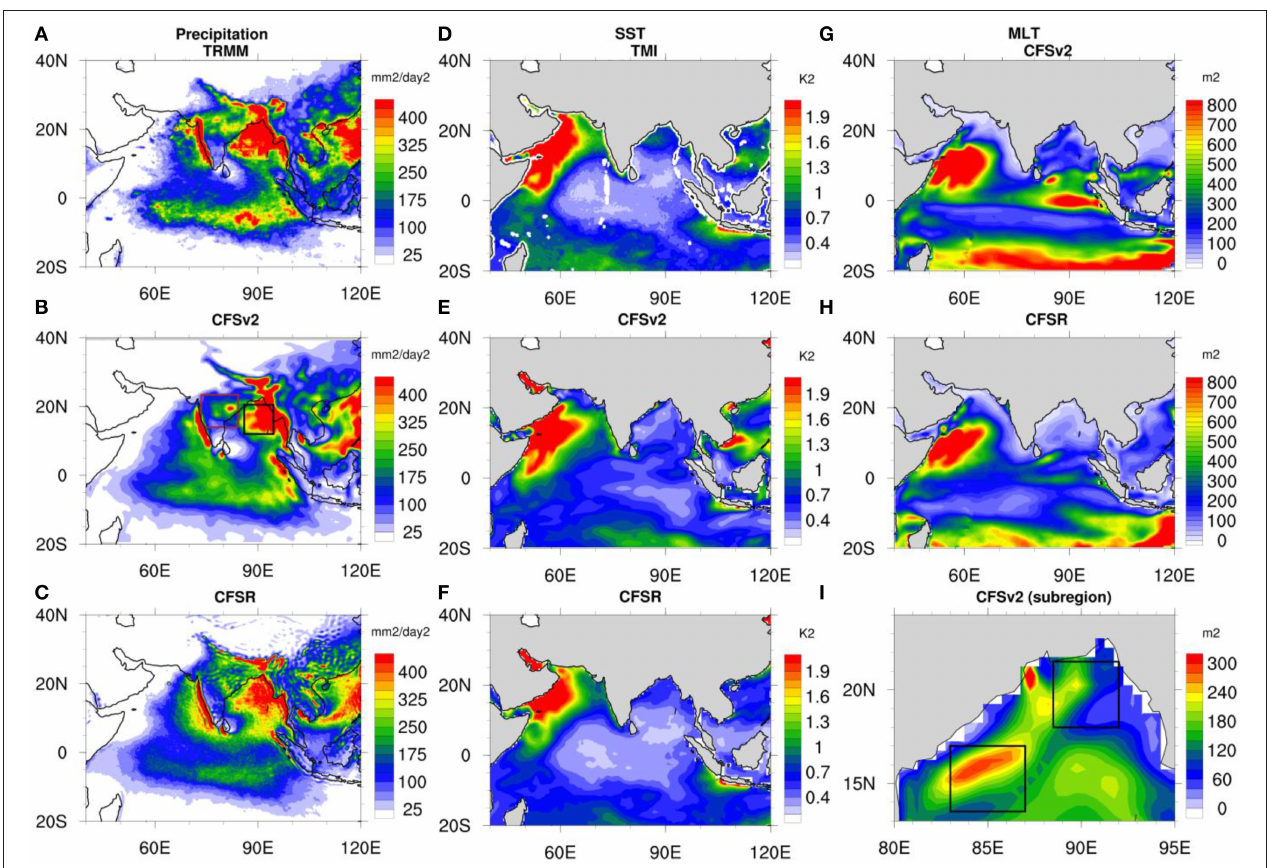
FIGURE 4 | Spatial distribution of daily variances of precipitation (left panel) from (A) TRMM, (B) CFSv2, and (C) CFSR; SST (middle panel) from (D) TRMM, (E) CFSv2, and (F) CFSR. Contour interval is 0.5 ( ◦ K)2; MLT (G) CFSv2 and (H) CFSR. The spatial distribution of ML variances over BoB is shown in (I) . Solid brown and black boxes in (B) represents the NCEN and BoB regions, and solid black boxes in (I) indicates the northern BoB (17–21 ◦ N 88–92 ◦ E; NBoB) and southern BoB (12–16 ◦ N, 84–87 ◦ E; SBoB). MSE budgets are performed over NCEN and BoB and ML budgets are performed over NBoB and SBoB,